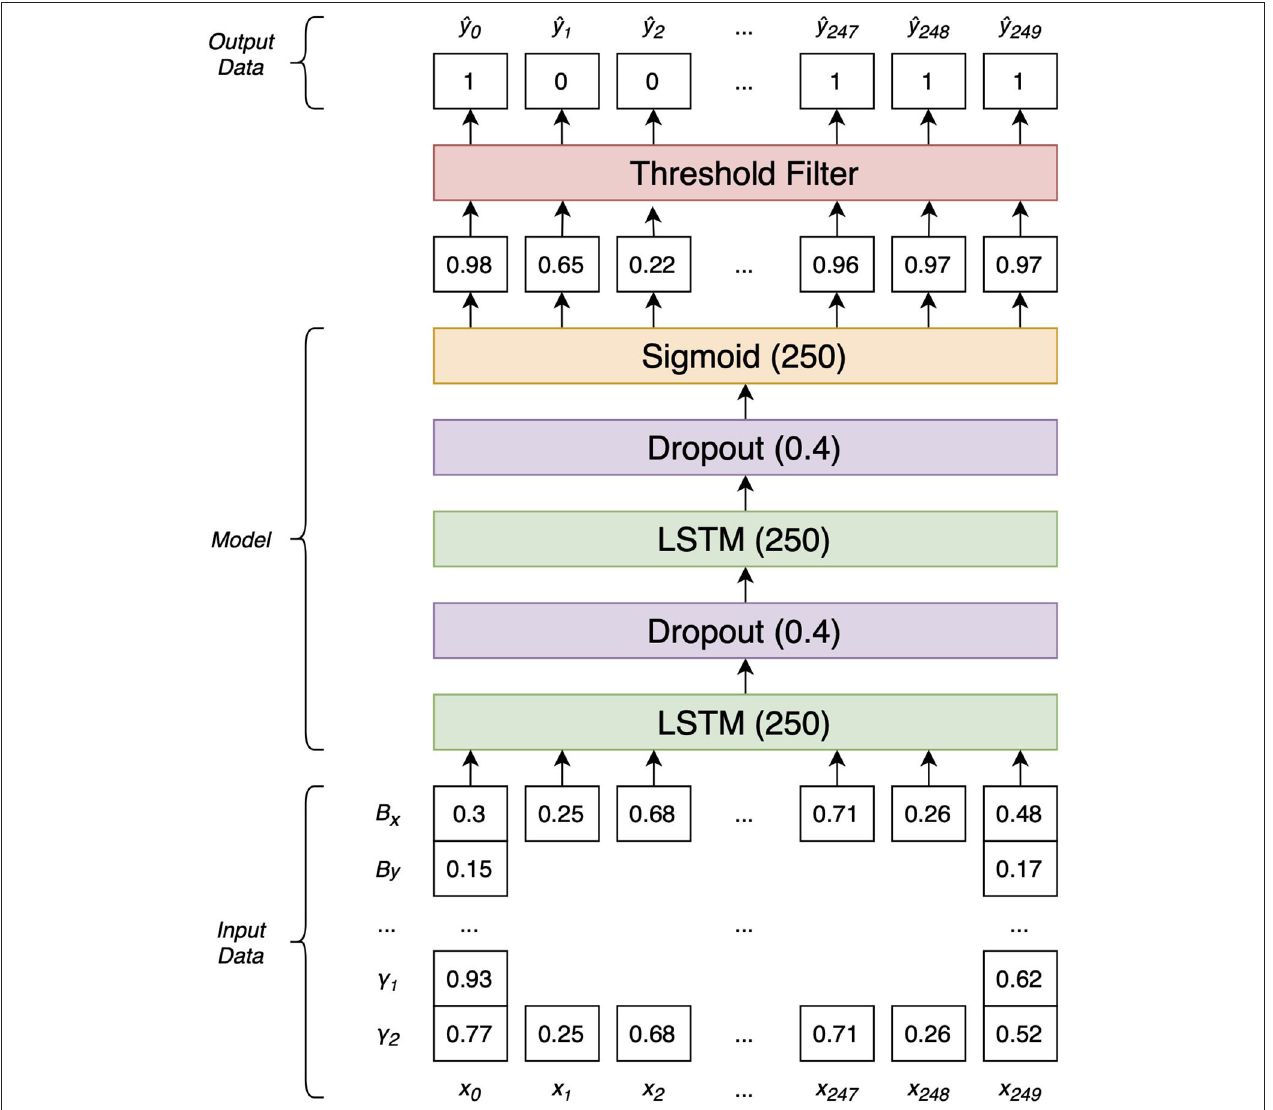
FIGURE 3 | The Architecture of the GLS magnetopause model mimicks how scientists interpret data. It makes decisions by placing data in the context of past and future